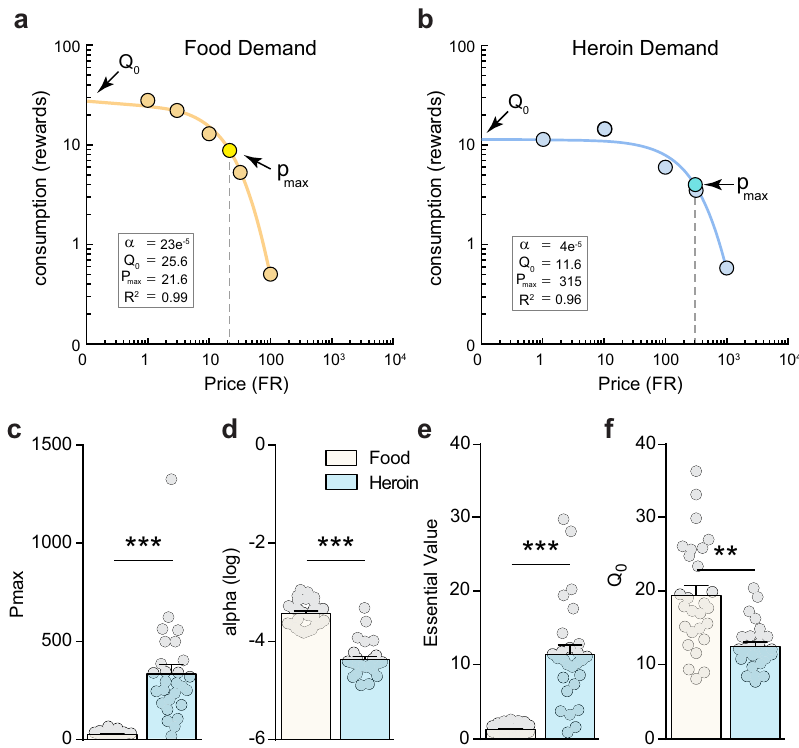
Fig. 1 Rats value heroin more than food. Representative demand curves for food ( a ) and heroin ( b ) for a single rat. c Rats are more motivated for heroin than for food as assessed by a higher Pmax, the maximum price animals are willing to pay to maintain consumption before levels drop off (two-tailed paired t -test, t (26) = 6.34, p = 5.12×10 − 7 ). d Heroin demand is less elastic than food demand (responding drops more rapidly for food as price increases; two-tailed paired t -test, t (26) = 11.2, p = 9.70×10 − 12 ) and correspondingly e heroin has a higher essential value than food (two-tailed paired t -test, t consume more food than heroin at low price points as indicated by a higher Q 0 value (two-tailed paired t -test, t (26) = 4.87, p = 2.40×10 − 5 ). n = 27 rats. *** p < 0.001, ** p <0.01 comparing between heroin and food behavioral economic variables. Data were presented as mean±SEM ( c – f